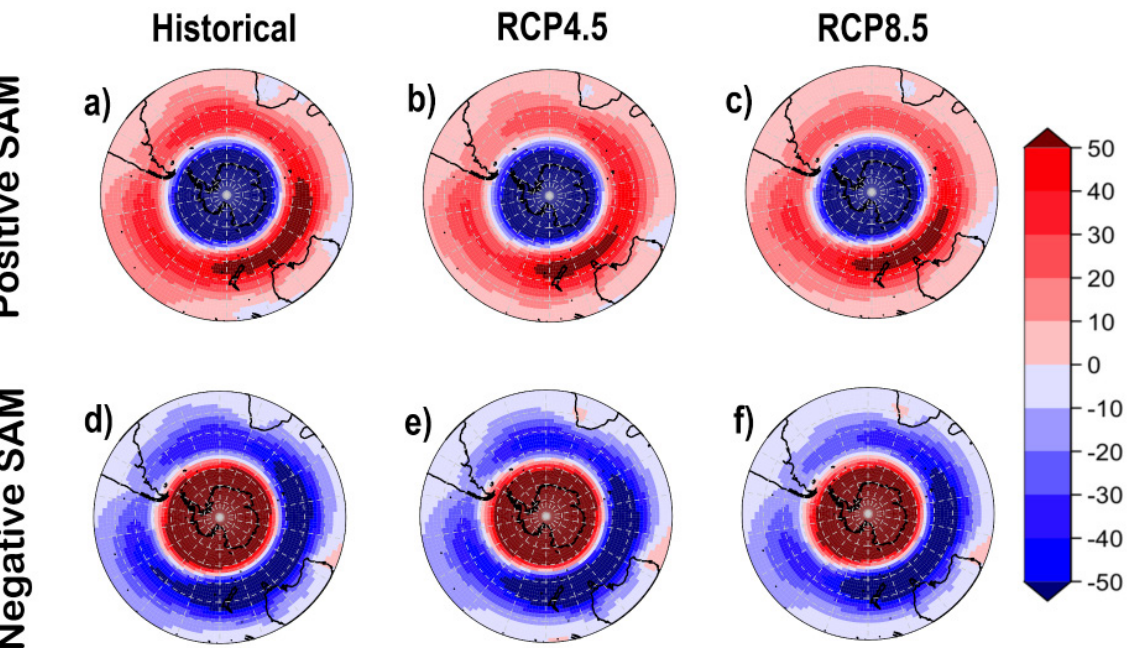
Figure 4. SAM positive and negative phases SLP composites for a) and d) Historical, b) and e) RCP4.5, and c) and f) RCP8.5. Composites were obtained for MSLP anomalies exceeding |2| standard deviation in the SAM index time